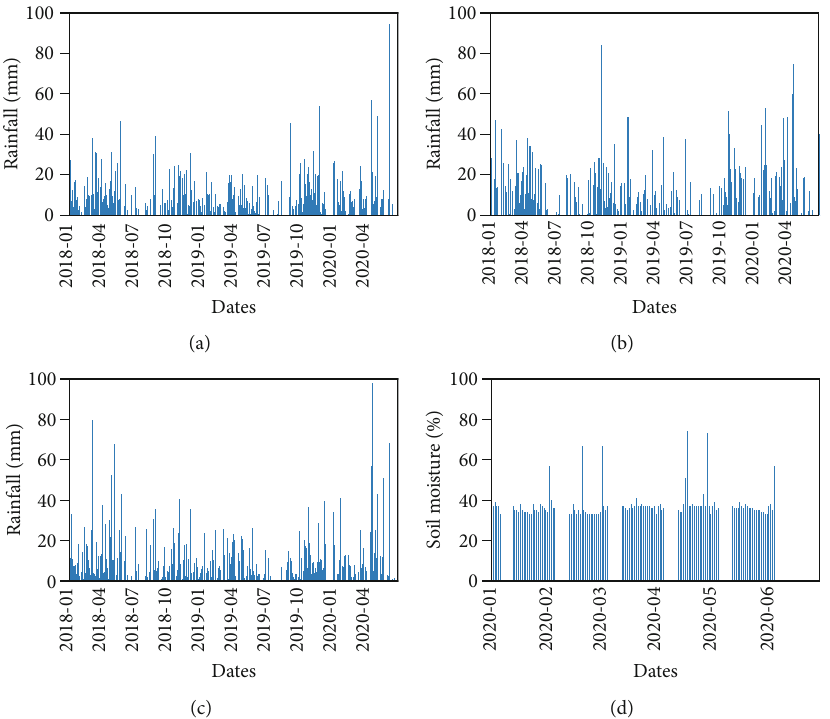
Figure 4: Past daily rainfall in the district of Gakenke from three rain gauge stations and one soil moisture station: (a) Janja, (b) Minazi, (c) Nemba, and (d) Rushashi soil moisture station.